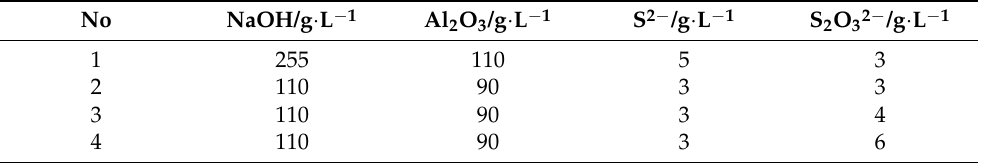
Table 1. Chemical composition of the sulfur-containing sodium aluminate solutions.